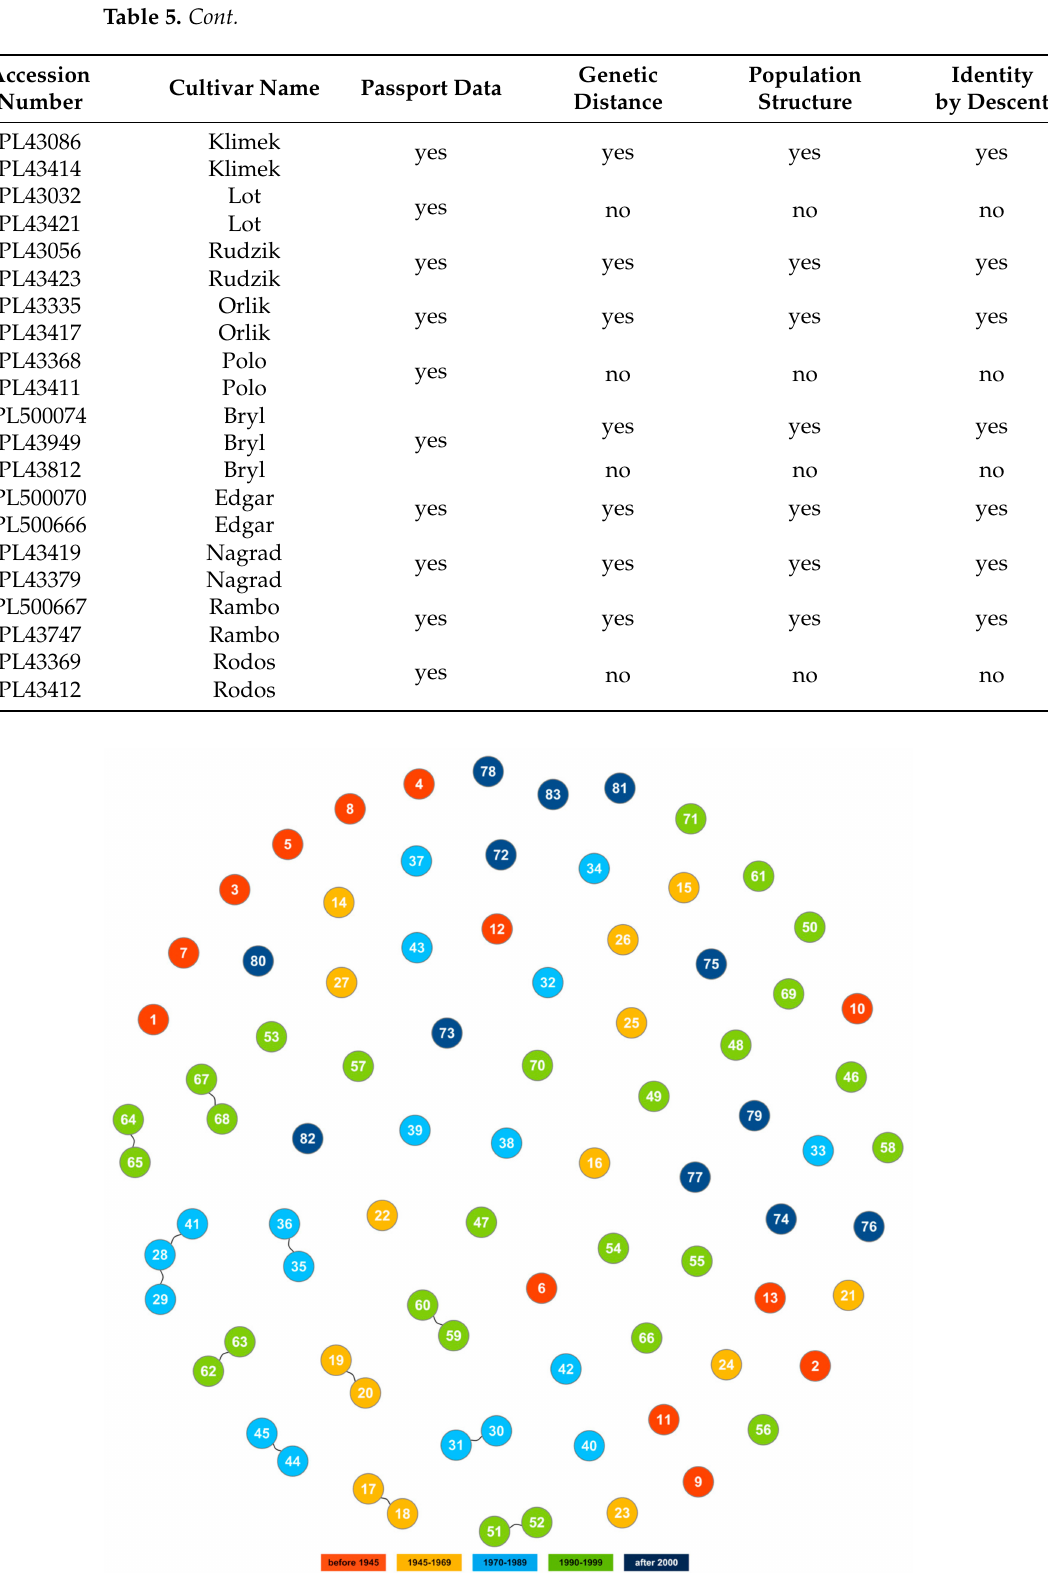
Figure 12. Identity by descent (IBD) based clustering of spring barley cultivars with cutoff at 0.95. Accession numbers according to Table